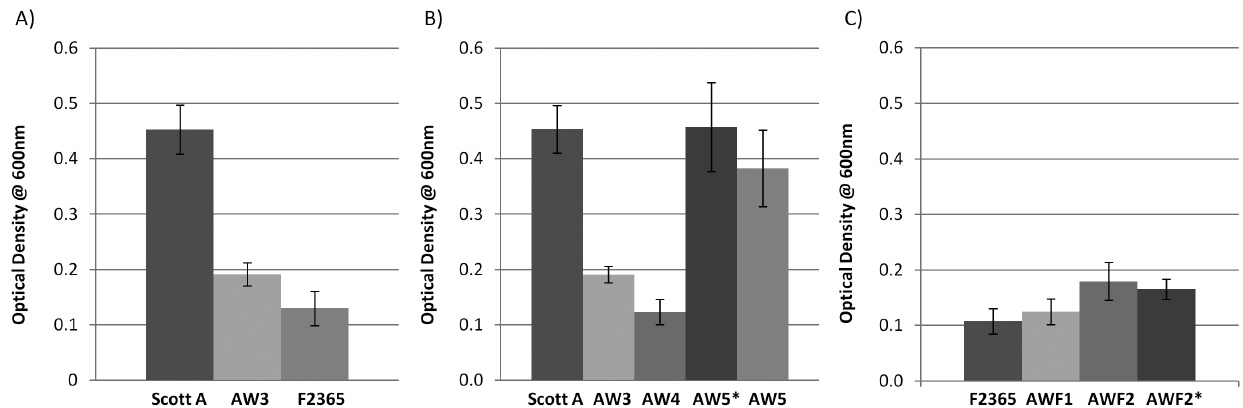
Figure 1. Rapid crystal violet attachment assay of A) Bfm s Scott A, lbrA deletion mutants AW3, Bfm w F2365; B) Scott A and lbrA deletion derivative AW3, vector control AW4, lbrA deletion complementing derivative AW5 with 25ng/mL nisin (AW5*) and without nisin (AW5); C) F2365, expression vector control transformant AWF1, Scott A lbrA expression derivative AWF2 without (AWF2) and with nisin induction (AWF2*). The error bars represent the standard error of the mean values.